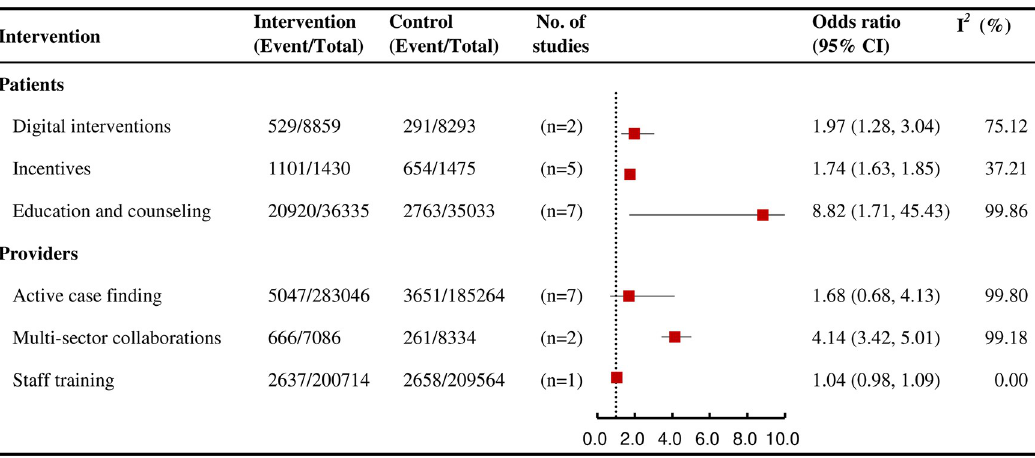
Fig 3. Forest plots showing the effects of various interventions on TB testing outcomes for active